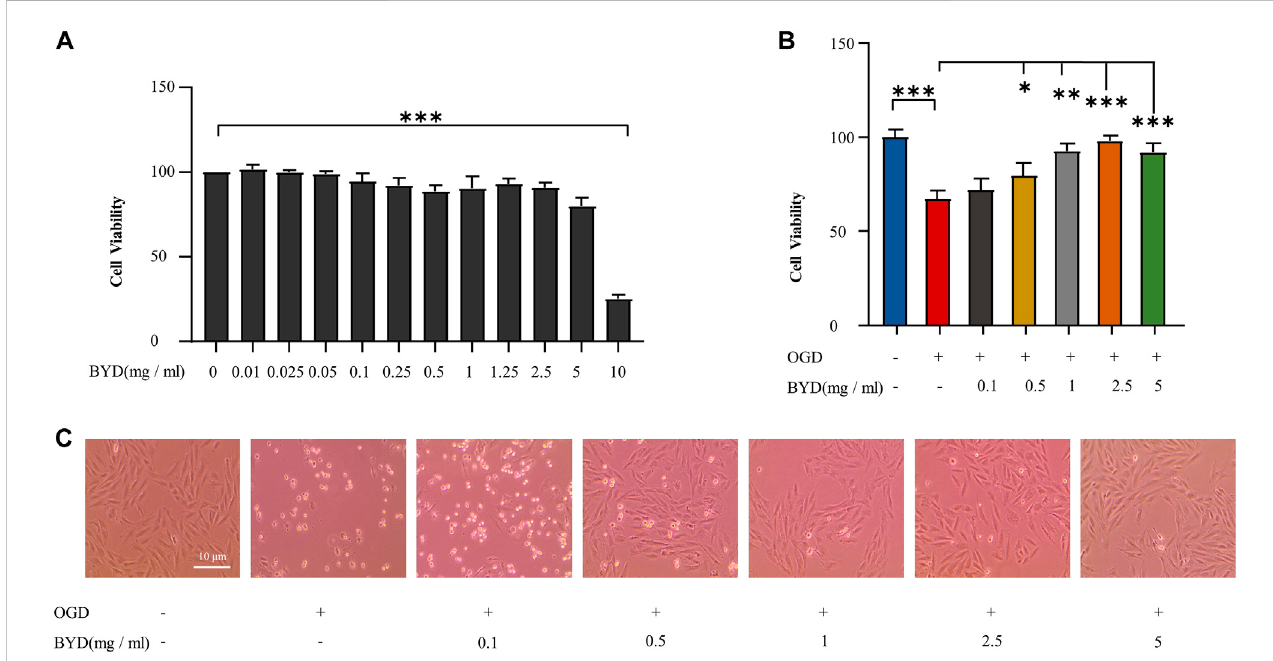
FIGURE 3 In vitro evaluation of BYDE for the cytoprotective effect against OGD challenge. (A) Effect of BYDE on the cell viability of H9c2 cells. Following BYDE treatment, the cell viability of H9c2 cells (n = 5) was examined by MTT assay. (B) Cytoprotective effect of BYDE on the viability of H9c2 cells against OGD challenge. Upon BYDE pretreatment and OGD challenge, the viability of H9c2 cells (n = 5) was determined by CCK-8 assay. (C) Effect of BYDE on the morphology of H9c2 cells against OGD challenge. Upon BYDE pretreatment and OGD challenge, the morphology of H9c2 cells (n = 3) was examined under a microscope.